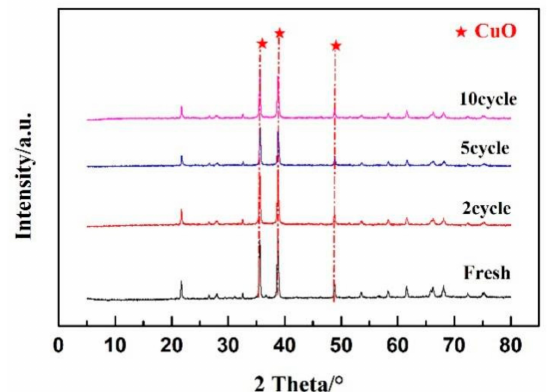
Figure 9. A 10-cycle regeneration test with variations of XRD spectra.